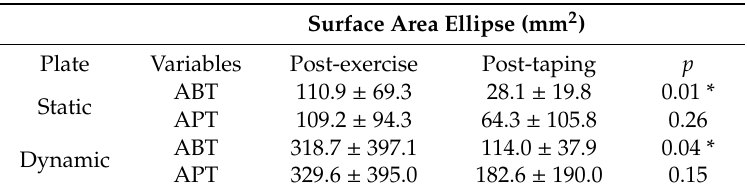
Table 4. Comparison of variations in surface area ellipses on a static and a dynamic plate with eyes open after fatigue-inducing exercise and after taping.